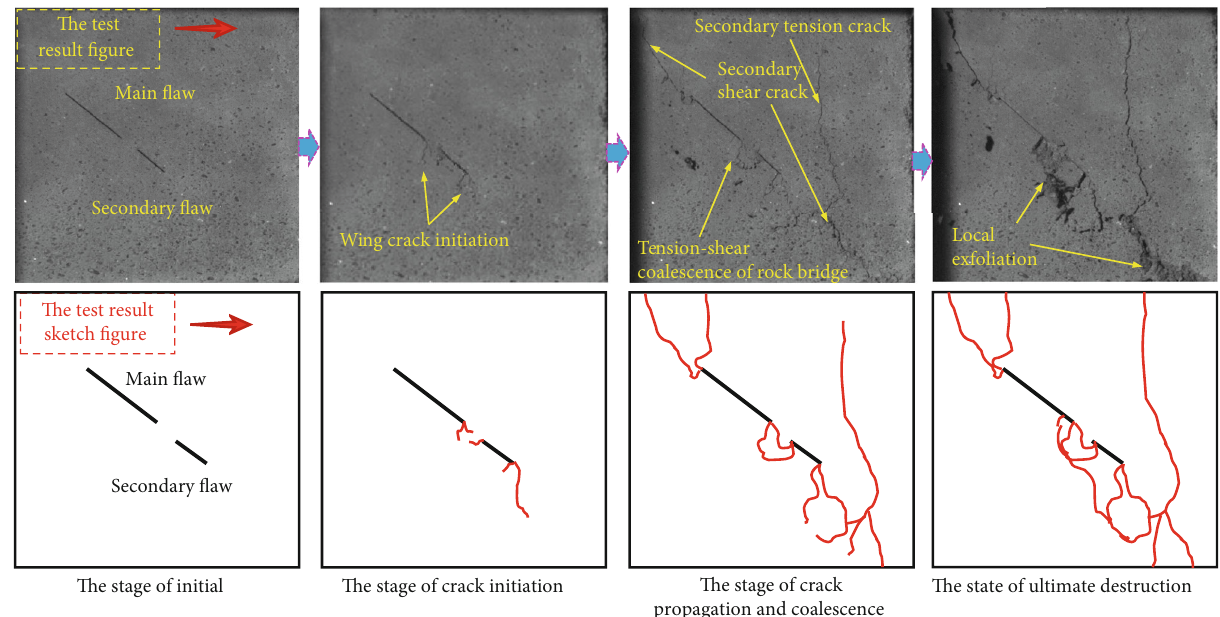
= 24 mm , 2 l = 12 mm , 2 d = 6 mm 1 2